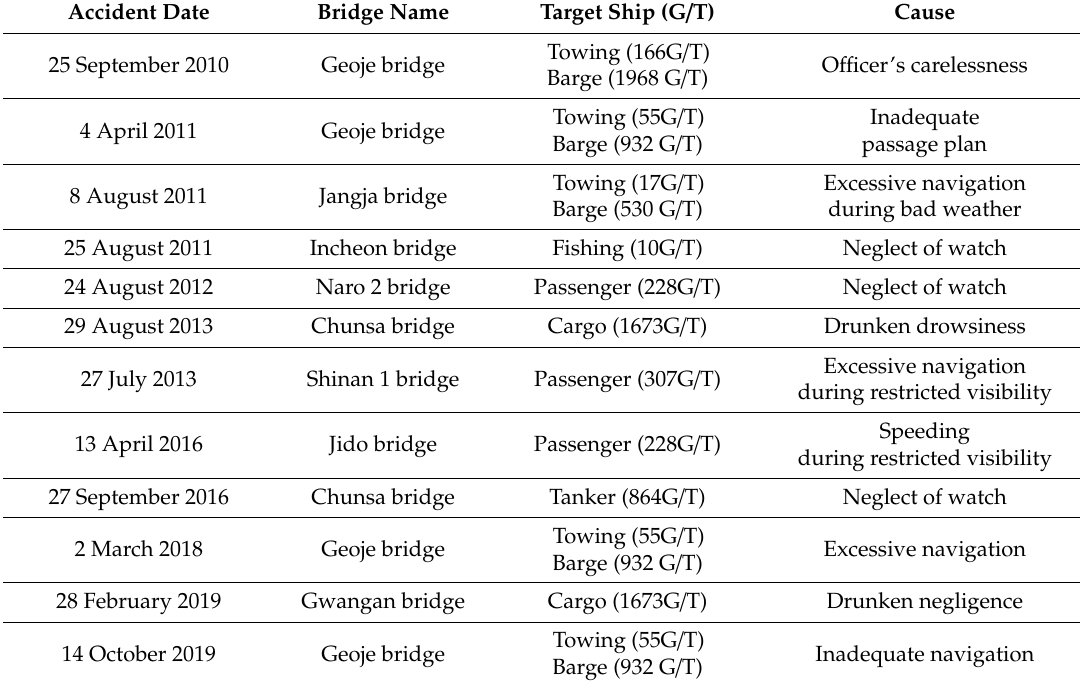
Table 16. Maritime accidents in Korea associated with bridges for